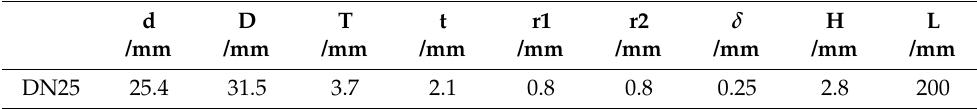
Figure 7. The structure of the DN25 bellows. Table 2. The dimensions of the DN25 bellows.